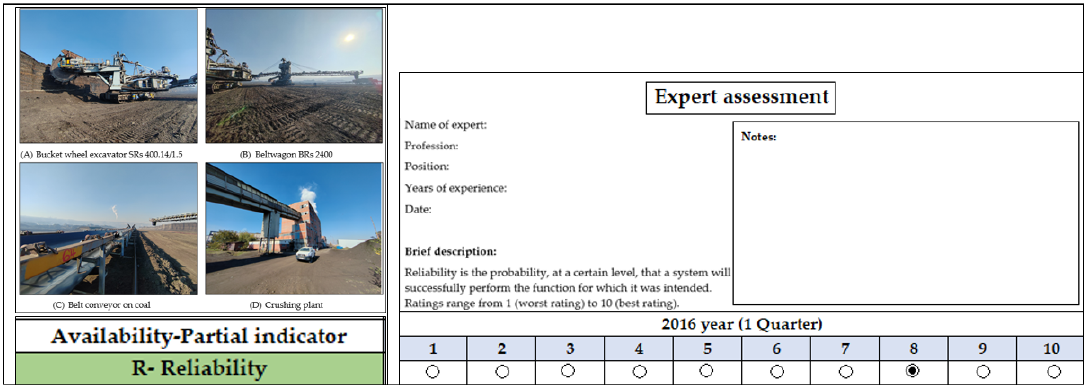
Figure 11. Survey layout for one partial indicator (R-reliability for 1 Quarter).